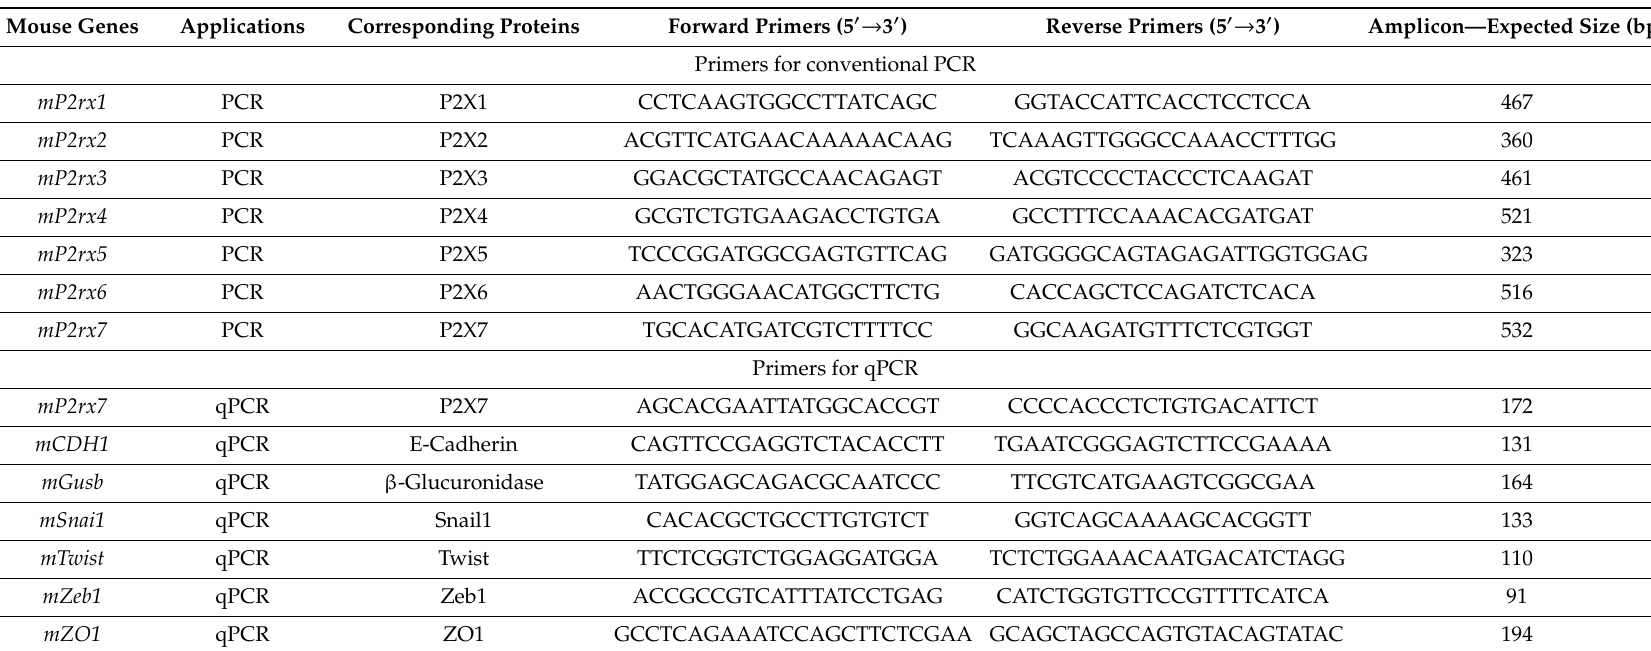
Table 1. Sequences of conventional Polymerase Chain Reactions (PCR) and quantitative Polymerase Chain Reactions (qPCR) primers and expected amplicon size. Mouse